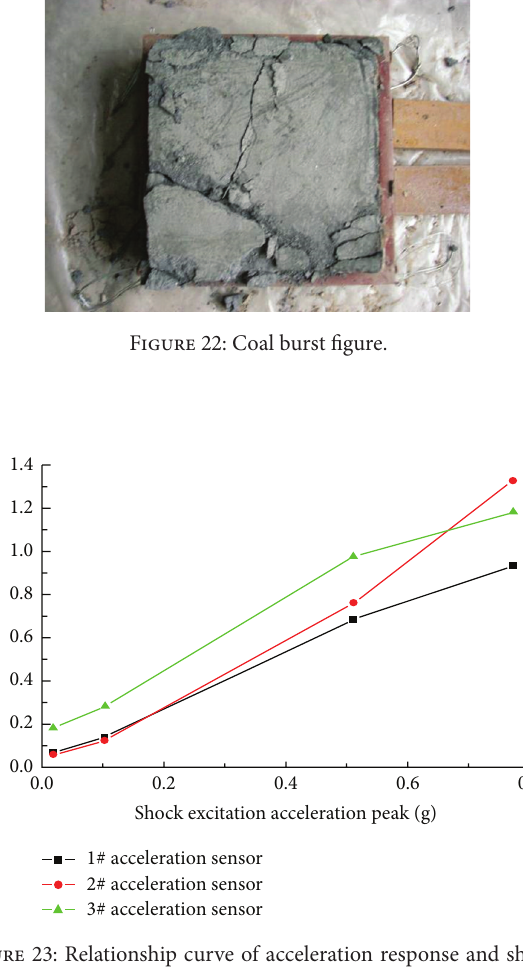
Figure 23: Relationship curve of acceleration response and shock excitation acceleration peak value.